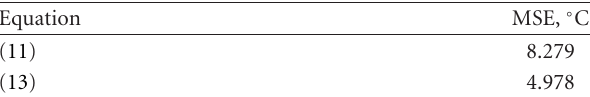
Table 4: Mean square error values. Daily average data.